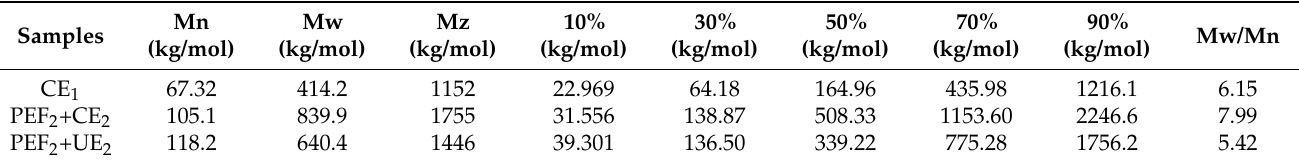
Figure 5. Elution curves of Se − TPSs using gel permeation chromatography. Table 4. The molecular weights of Se − TPSs *.